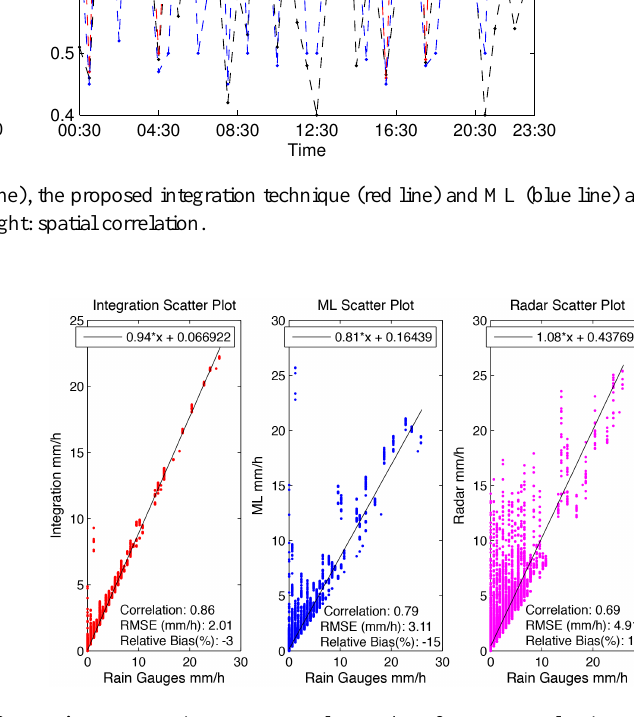
Figure 10. Rain rate scatter plots and performance evaluations of the integration (left), ML (middle) and radar (right) with respect to all the available rain gauges for event 1.